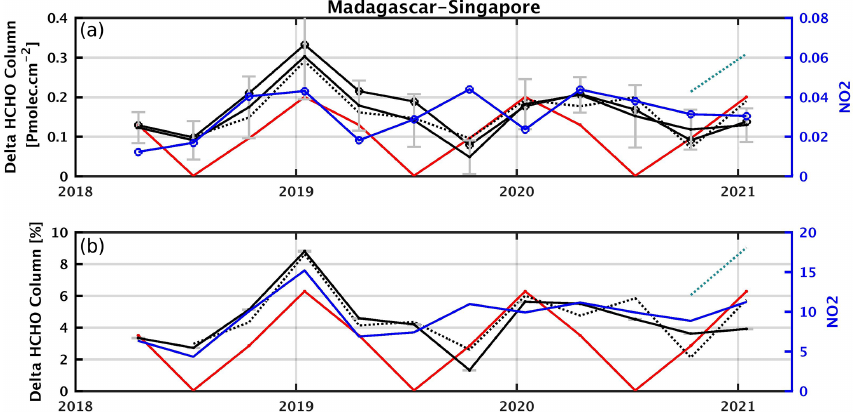
Figure 22. Same as Fig. 21 along the Madagascar–Singapore